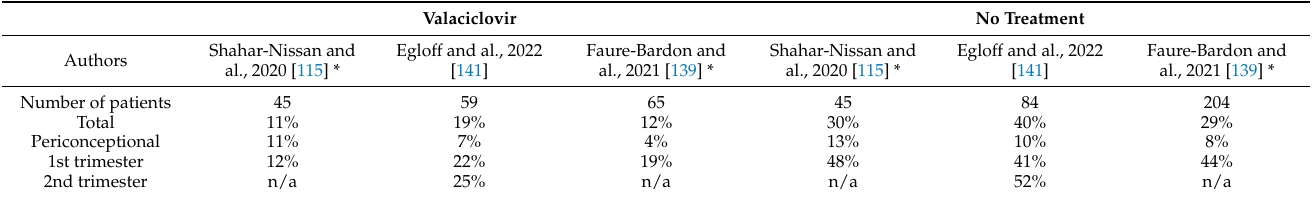
Table 2. Vertical transmission rate according to gestational age at the onset of primary infection in different studies evaluating valaciclovir for the secondary prevention of maternal–fetal transmission of CMV